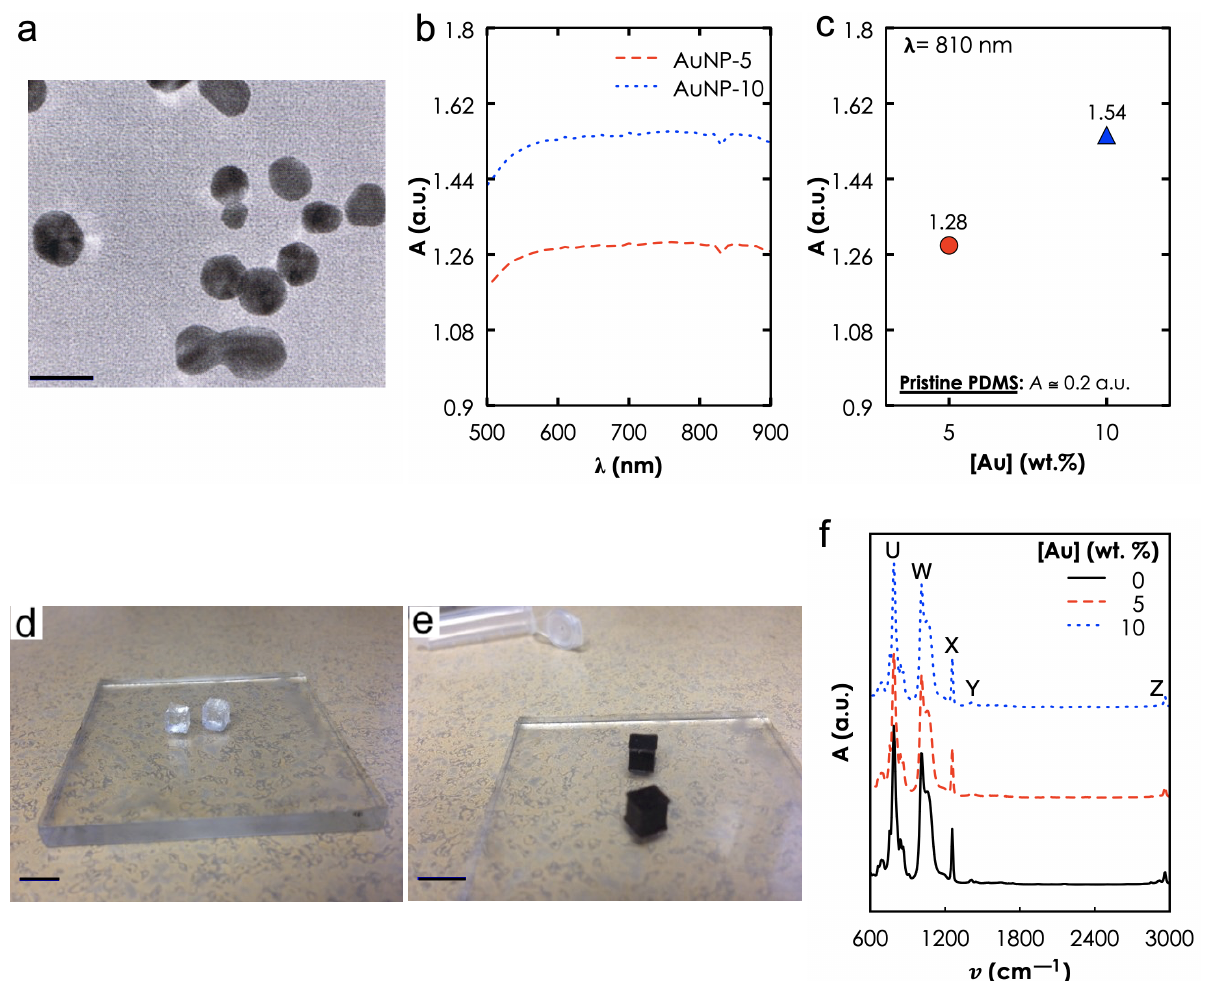
Figure 3. Materials characterization results. ( a ) Transmission electron microscopy (TEM) of the Au nanoparticles (AuNPs), Scale bar: 30 nm, ( b ) UV-vis-near infrared (NIR) absorbance spectra of the Gold and Poly dimethylsiloxane (Au-PDMS) nanocomposites at different [Au]: 5 and 10%. Absorbance as a function of ( c ) wavelength ( λ ) and ( d ) [Au] at λ = 810 nm. Photographs of fabricated samples (Scale bar: 4.5 mm): ( d ) AuNP-0 and ( e ) AuNP-10. ( f ) Fourier transform infra-red of all three